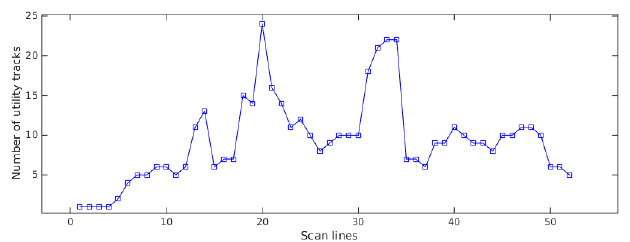
Figure 12. Number of utility tracks on different scan cross-sections (scss).